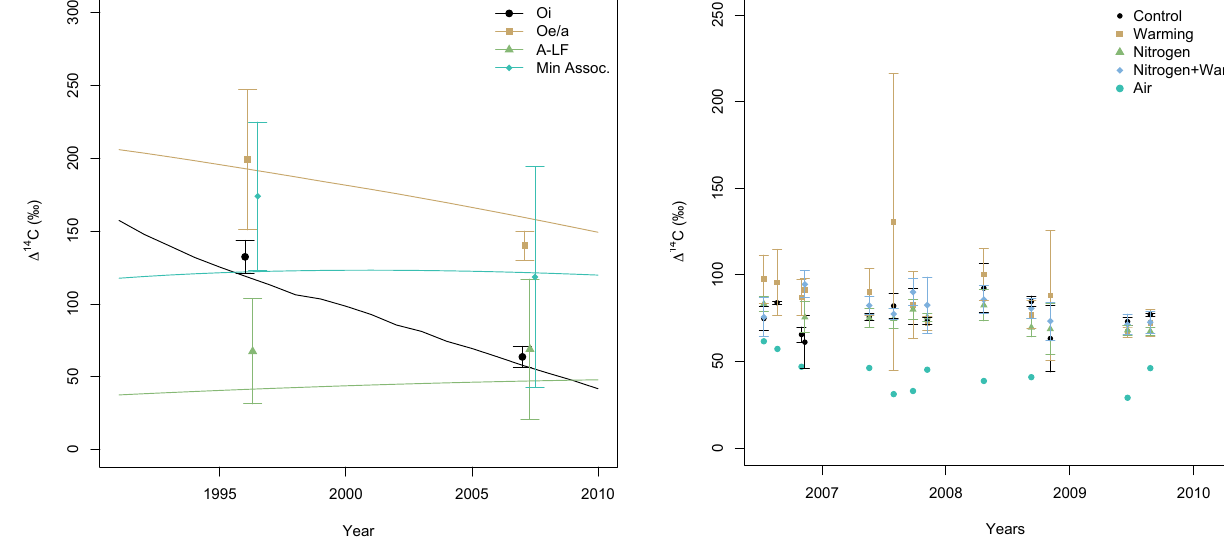
Fig. 4. Radiocarbon in respired CO 2 measured in field traps at treat- ments and sampling dates between 2006 and 2010. Bars represent the standard deviation of the sample at each sampling